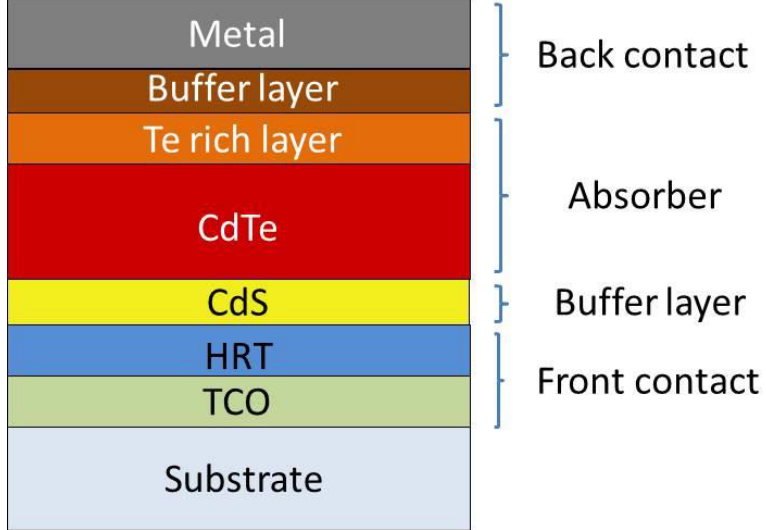
Figure 1. Structure of a standard superstrate CdTe solar cell .